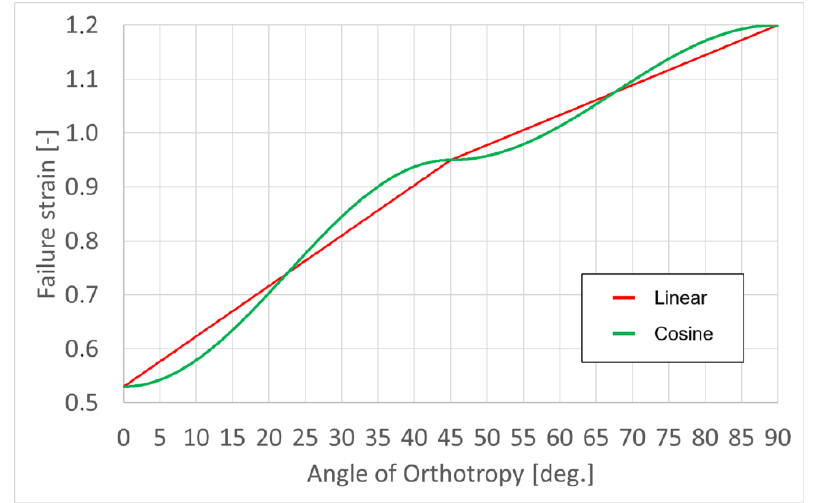
Figure 11. Comparison between linear and trigonometric interpolation of the failure strain curves, for a triaxiality of 1/3. triaxiality of 1 /